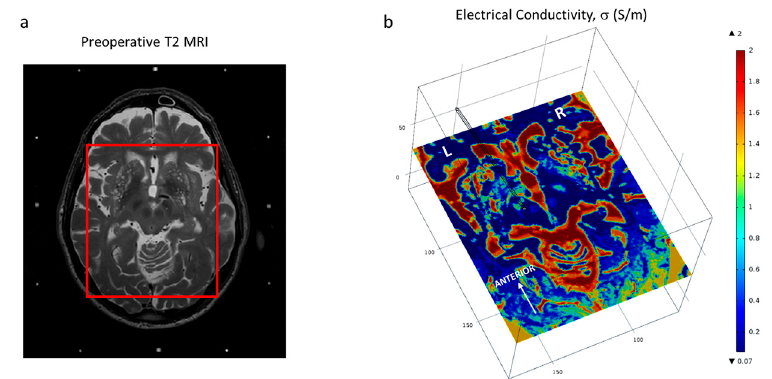
Figure 2. ( a ) Demarcation of the region of interest on the patient T2 MRI dataset (cauda-cranial point of view) and ( b ) Brain model displaying one slice of the interpolated conductivity matrix (cranio-caudal point of view) and the trajectory of the lead. Axial images displayed at the level of the ZI.